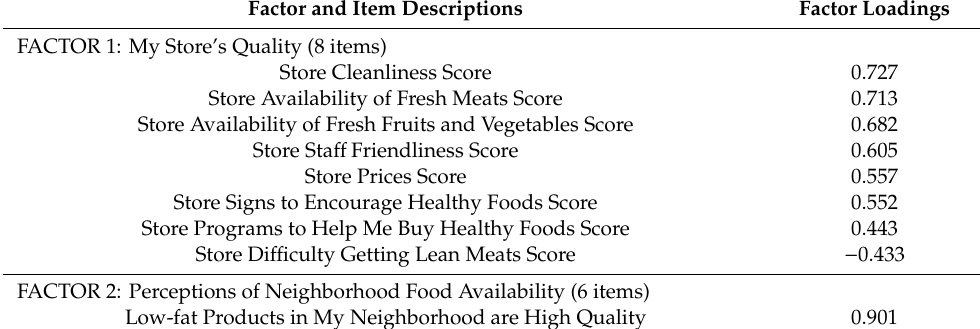
Table 2. Factors, Items, and Factor Loadings Identified in Exploratory Factor Analysis of FIONS Participant Survey a